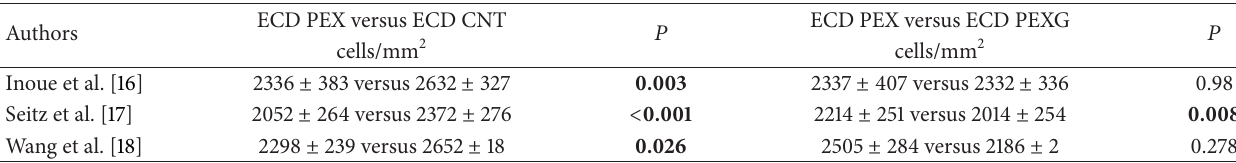
Table 3: Result summary of research comparing cell density of the corneal endothelium (ECD) of patients with PEX syndrome to the ECD of people without PEX syndrome and PEX to PEXG.